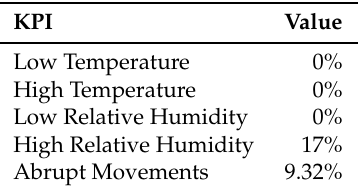
Table 3. KPI results obtained in transport phase.